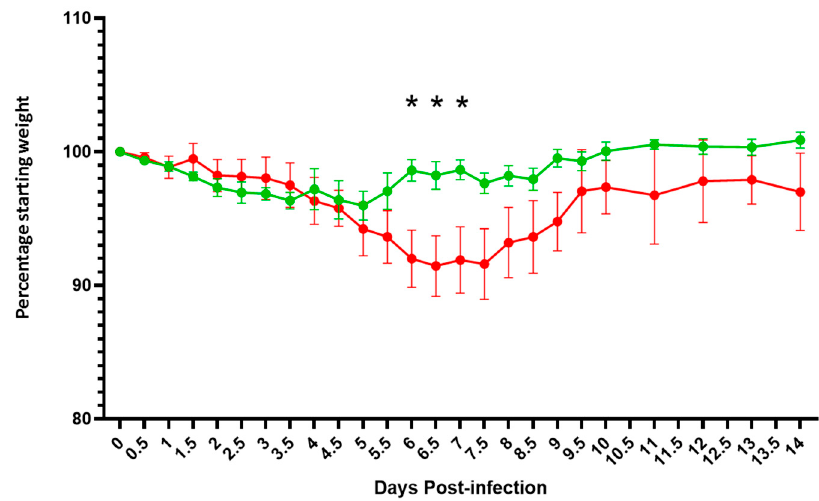
Figure 9. Average weight loss in both Syrian hamster groups, one immunized with VLP (green) and the other control (red), following live virus challenge. Animals were weighed twice a day (AM and PM) and the average weight and variation among the group plotted. Significant deviation between the groups ( p < 0.05, ANOVA post-hoc Bonferroni) is indicated (*). Following post mortem, the lungs (right cranial and left) of selected animals in both groups were examined for overt signs of pathology, one animal each at 2 days post challenge, and two animals each at days 10 and 14 post challenge. At day 2 markers in the right cranial and left lung were similar for each animal although the single highest severity score, for alveolar wall necrosis, was found in the control animal. At day 10 the VLP treated group had much reduced overall scores, particularly for markers of inflammation, when compared to the control although the distinction between the groups was lost by day 14 (Table 1). Differential pathology was also apparent following histochemical staining the VLP group showing markedly reduced bronchiolar and alveolar inflammation compared with control animals at 2 days post challenge, a feature which was retained to the end of the monitoring period at 10 days post-challenge (Figure 10, upper panels). Immunohistochemistry for the presence of the S protein in areas of inflamed lung tissue showed clumps of S positive syncytial cells were present in both groups but that the overall level of S protein was much higher in the non-vaccinated animals when compared to those immunized with the VLPs at both of the time points tested (Figure 10, lower panels).